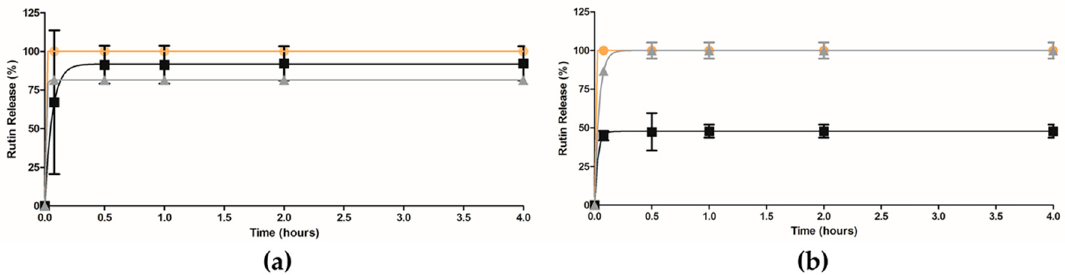
Figure 9. Percentage of the major compound (rutin) release over time in ( a ) PBS at pH 5.5 and ( b ) PBS at pH 7.4: free extract (orange line), extract-loaded PLGA NPs (black line) and PCL NPs (grey line) (mean ± S.D.).